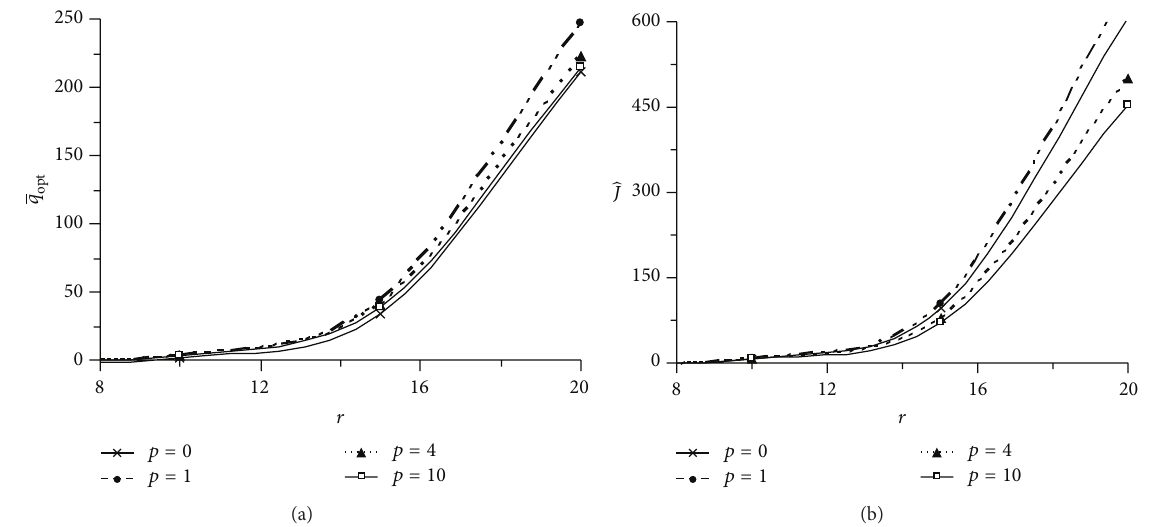
̂𝐽 , (b) for the energy , with ℎ = 0.02 m, 𝑎/𝑏 = 1 . opt